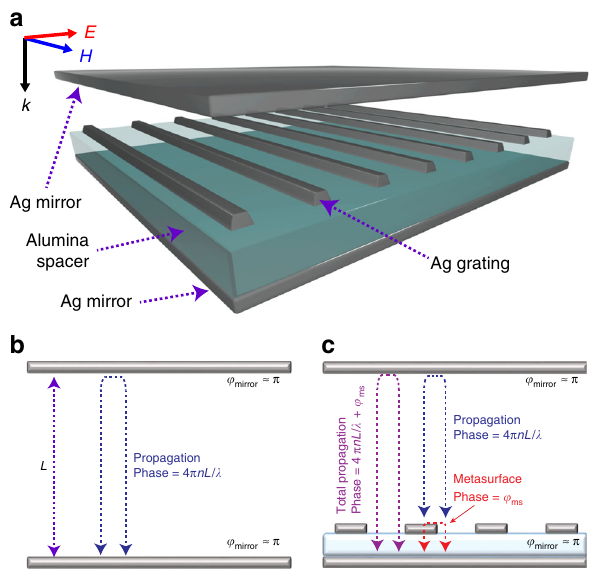
Fig. 1 Design and concept of metasurface-based nanocavity. a Schematic of the metasurface-based nanocavity. b , c Comparison in phase and resonance conditions between: b conventional Fabry – Pérot resonator that utilizes two parallel mirrors and c resonator with a re fl ecting metasurface placed in between the two